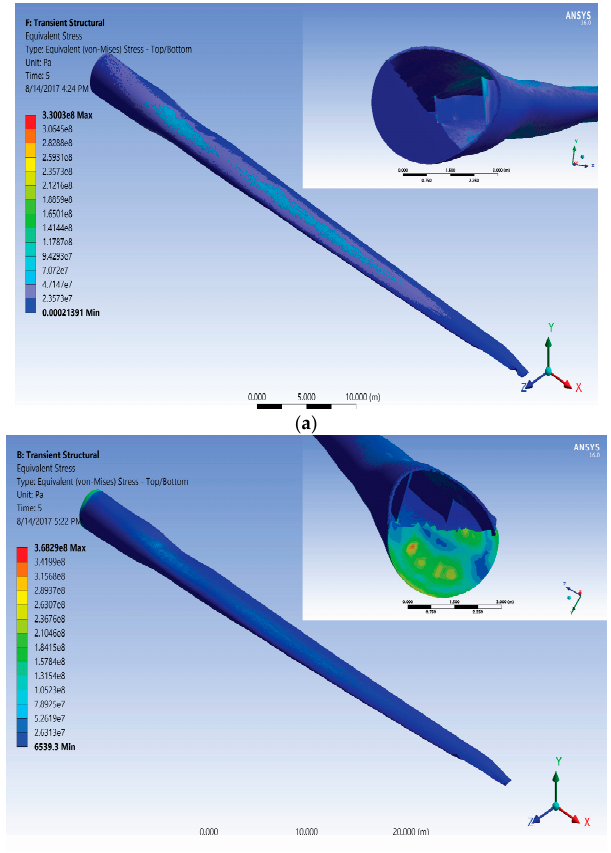
Figure 19. Von-mises stress contour at the end of 5 s; ( a ) uni-directional; and ( b ) bi-directional.